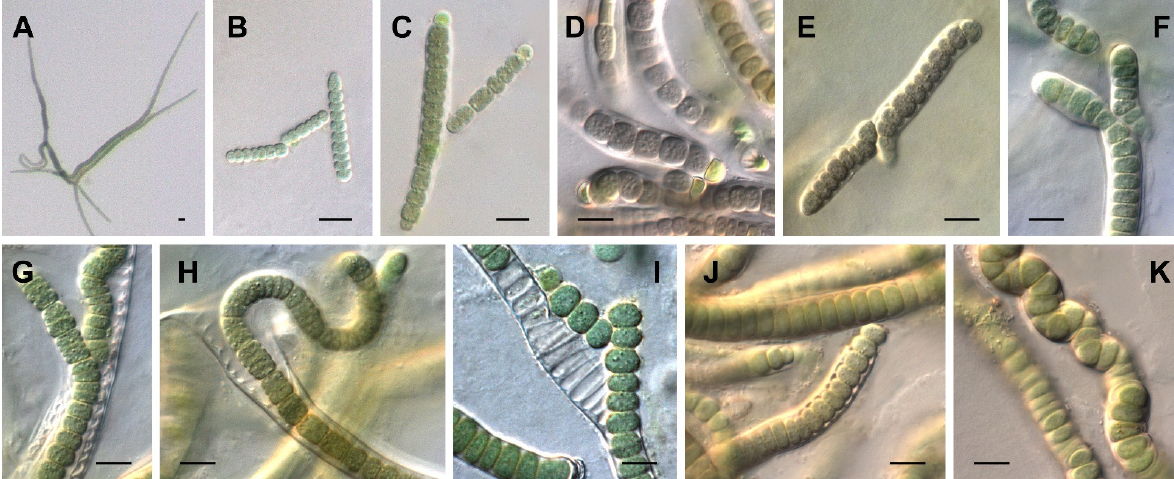
Figure 1. ( A ) Young trichomes, tapered to the ends, in liquid media; ( B ) hormogonia in liquid media; ( C ) young filaments with terminal heterocytes; ( D ) trichomes immediately after first isolation in pure cultures on agar solidified media; ( E ) the beginning of the false branching on agar solidified media; ( F ) the false branching in old culture on agar tubes with the liquid media; ( G ) false branching filaments, partly surrounded by the thick multilayered sheath in old culture on agar tubes with liquid media; ( H ) releasing of the filament from the thick multilayered sheath in old culture on agar tubes with liquid media; ( I ) release of arthrospores after the destruction of the sheath from the one side of the filament in old culture on agar tubes with liquid media; ( J ) release of arthrospores from the end of filament in old agar solidified cultures; ( K ) tightly coiled filaments in old agar-solidified media. Scale bar: 10 μ m.